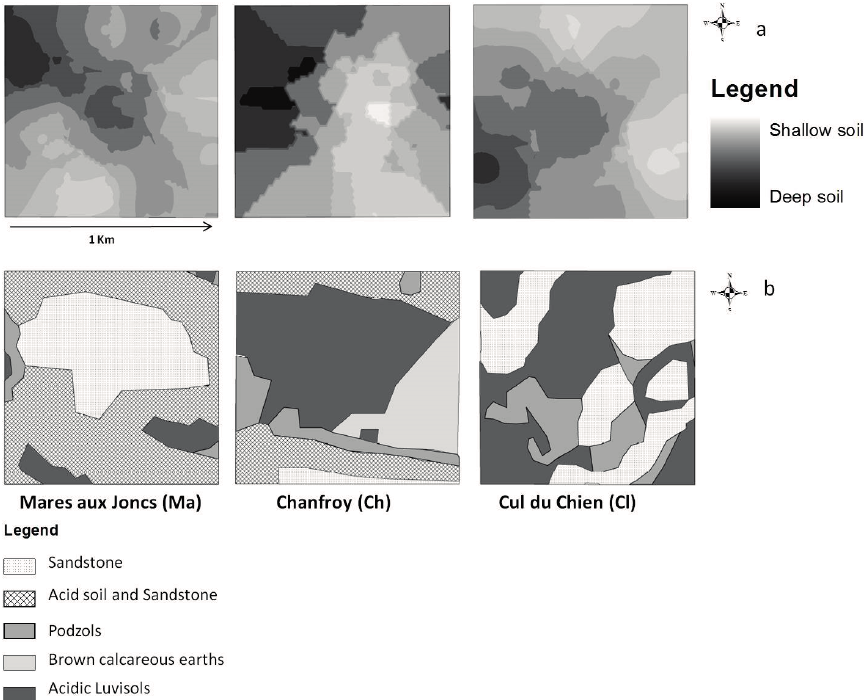
Figure 2. Soil map: ( a ) soil depth, ( b ) soil